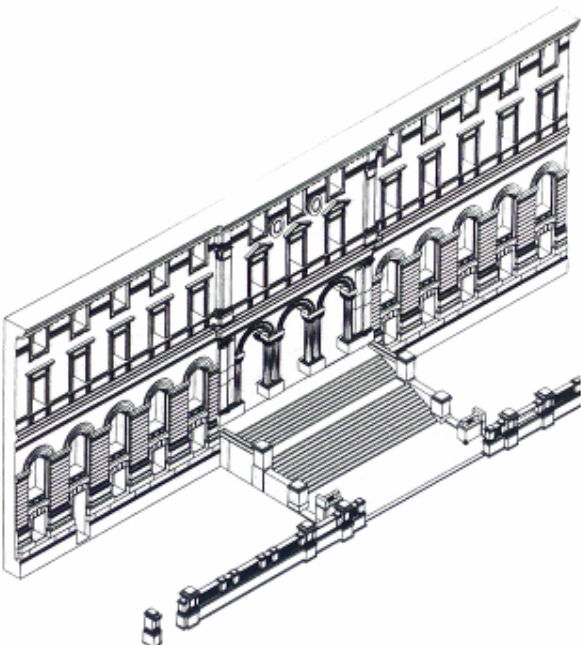
Figure 18. Axonometric view of the façade of the faculty of Engineering.